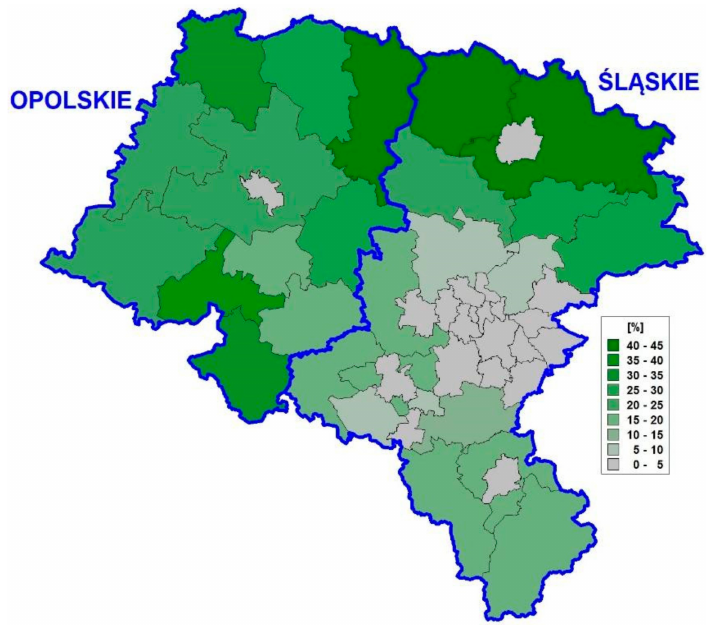
Figure 1. Population in agricultural sector in Upper Silesia